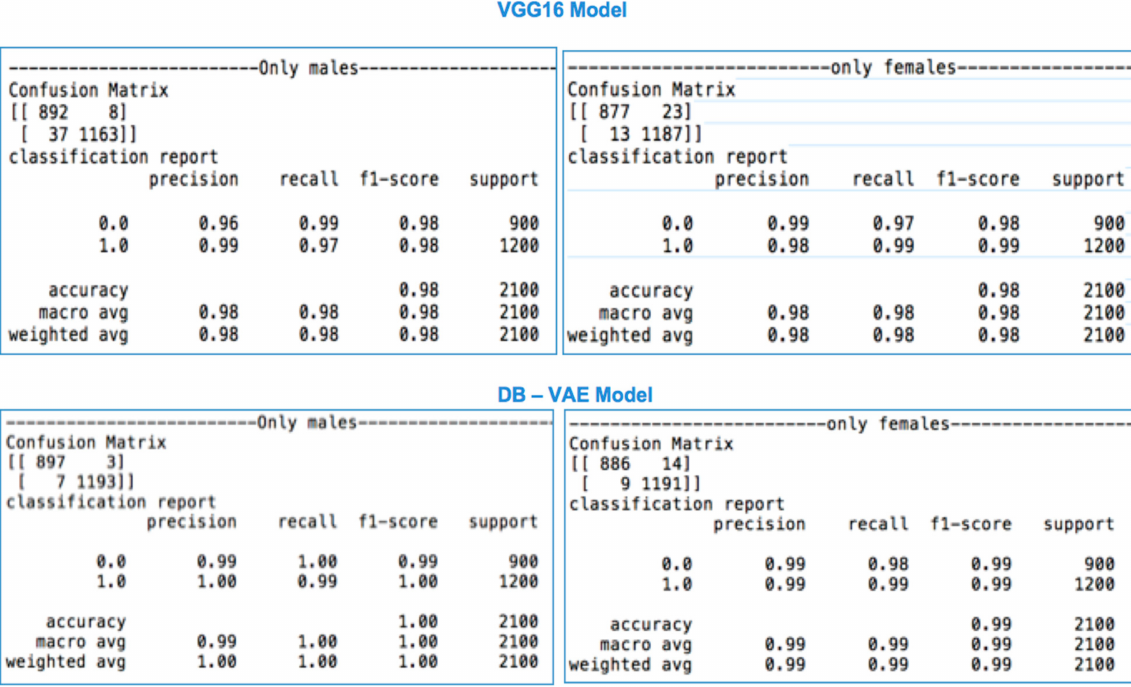
Figure 15. Confusion matrix and classification reports for phase